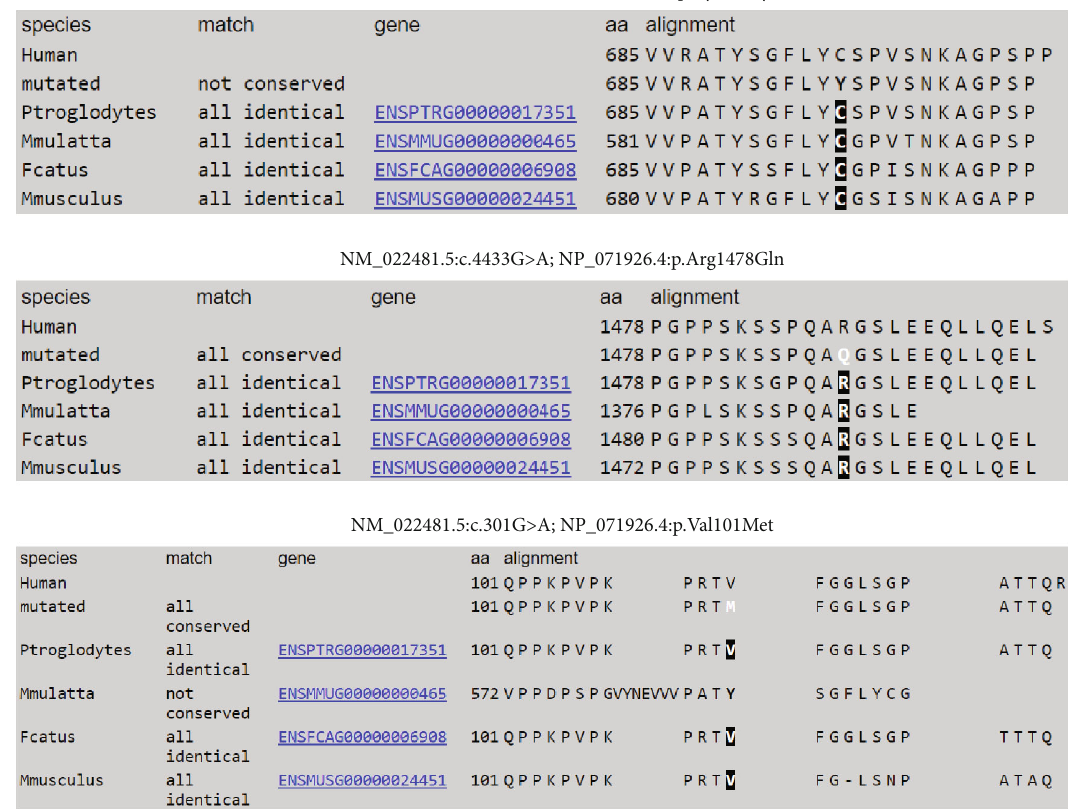
Figure 4: Conservative analysis of three identi fi ed variants in ARAP3 . This residue is preserved in the most relevant mammals including primates, felines, and model rodents such as Mus musculus . Table 3: Top ten models for 3D modeling of the ARAP3